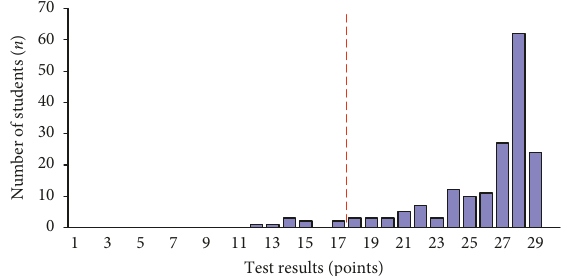
Figure 2: Distribution of points in the obligatory test of the control group (cohort 1, n � 219). This pattern corresponds to the average results of obligatory tests in pharmacology. The dotted line marks the passing grade of 60%.